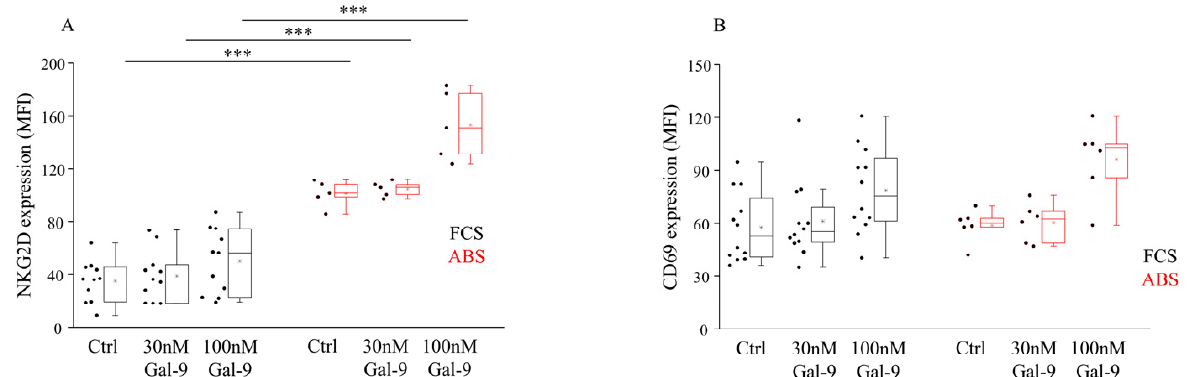
Figure 2. Activating receptor expressions by NK-92MI cell line cultured in medium supplemented with FCS or human ABS after recombinant Gal-9 treatment. The surface expression of activating NKG2D ( A ) and CD69 ( B ) receptors by NK-92MI cells following 30 and 100 nM Gal-9 addition cultured in medium supplemented with 10% FCS or 10% human ABS. The solid bars represent medians of 10 determinations, the boxes indicate the interquartile ranges, and the lines show the most extreme observations. Differences were considered statistically significant for p -values *** <